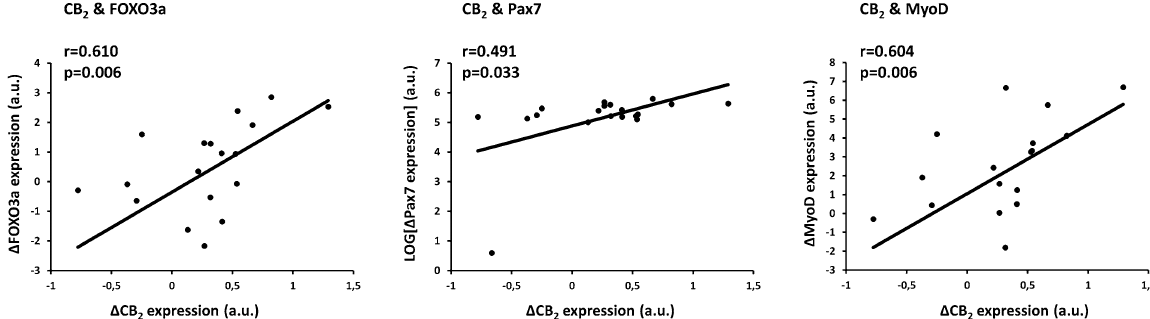
Figure 3. Pearson (normal data) or Spearman (non-normal data) correlations between the change (Δ; Post–Pre RE) in CB 2 expression and the change in forkhead box O 3a (FOXO3a), MyoD and Pax7 expression. Non- normal data are presented following 10